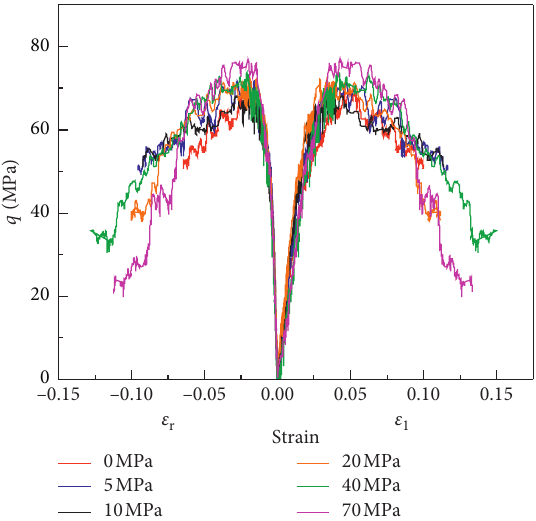
Figure 4: q - ε r and q - ε 1 curves of the PVC